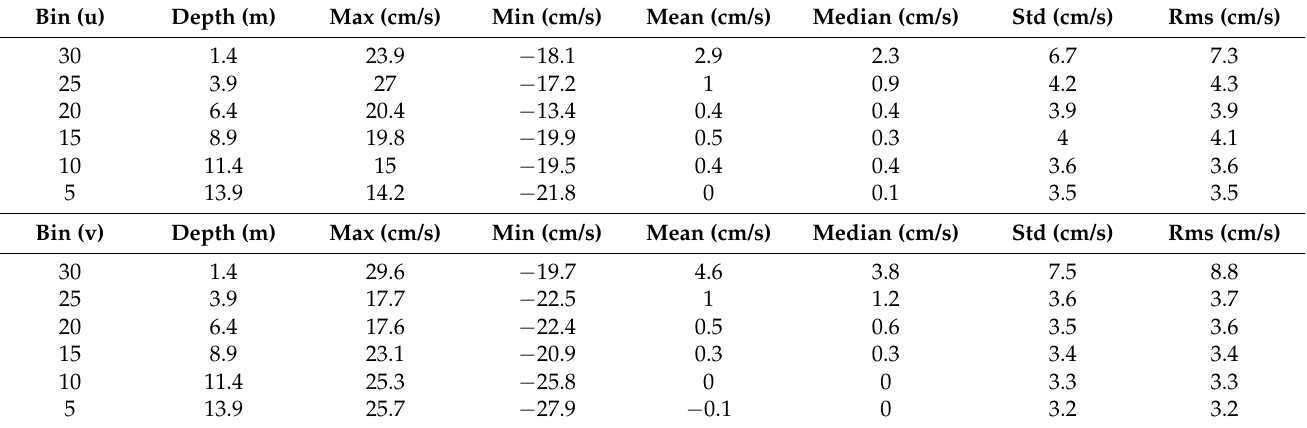
Table 5. Basic statistical properties of near-surface (bin 30) and near-bottom (bin 5) zonal (u) and meridional (v) current components for the April–June period.